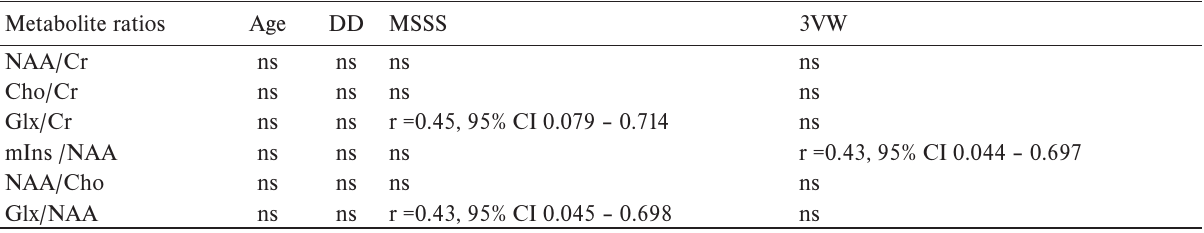
Table 4. Correlations of the metabolite ratios with clinical parameters and 3VW in RRMS patients. Metabolite ratios Age DD